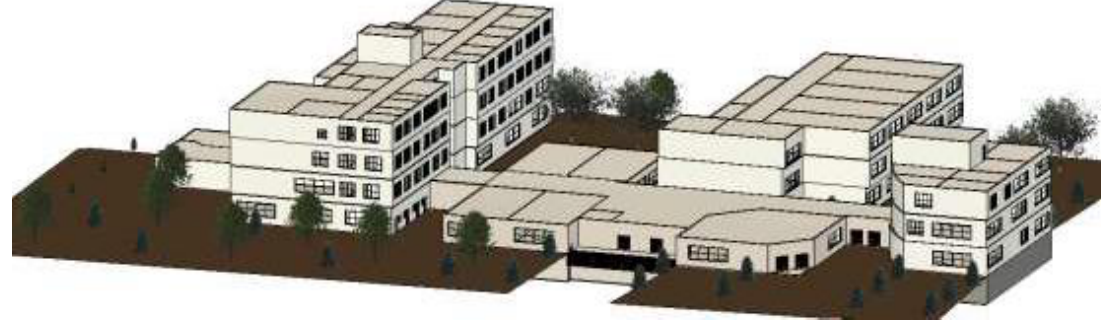
Figure 2. Photorealistic 3D rendering of the university building.